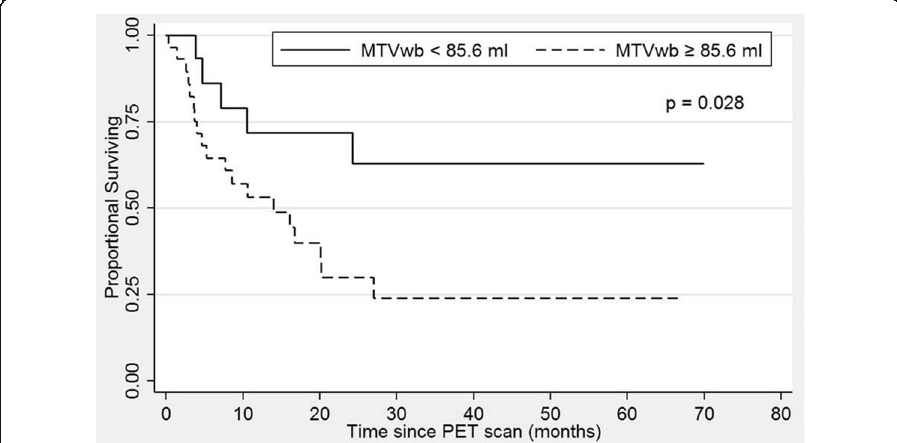
Fig. 3 Kaplan-Meier overall survival curves of the validation dataset of 44 patients with TNM stage 3B NSCLC, stratified by the median MTVwb of the training dataset, 85.6 mL. The dashed line represents the patient group with MTVwb ≥ 85.6 ml with median OS of 13.9 months. The solid line represents the patient group with MTVwb <85.6 ml with median OS not reached during follow-up period. The groups were significantly different with p =